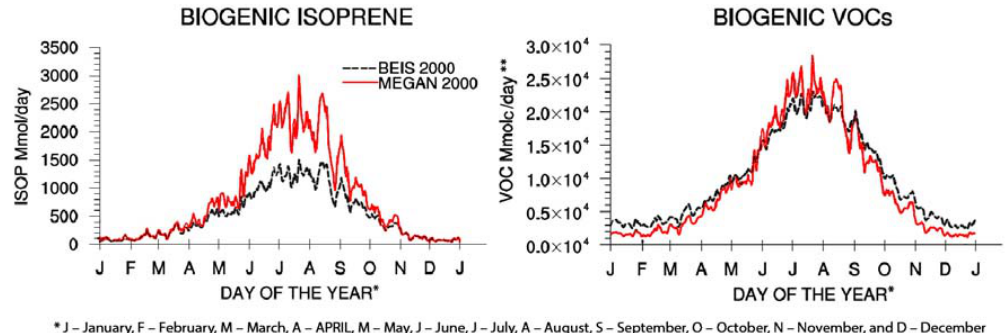
Fig. 2. CONUS 36 km daily domain totals of average biogenic emissions in 2000: (a) Fig. 2. CONUS 36km daily domain totals of average biogenic emissions in 2000: (a) biogenic isoprene and (b) total biogenic VOC. biogenic isoprene and (b) total biogenic VOC. land use and vegetation patterns as 2000 on all years